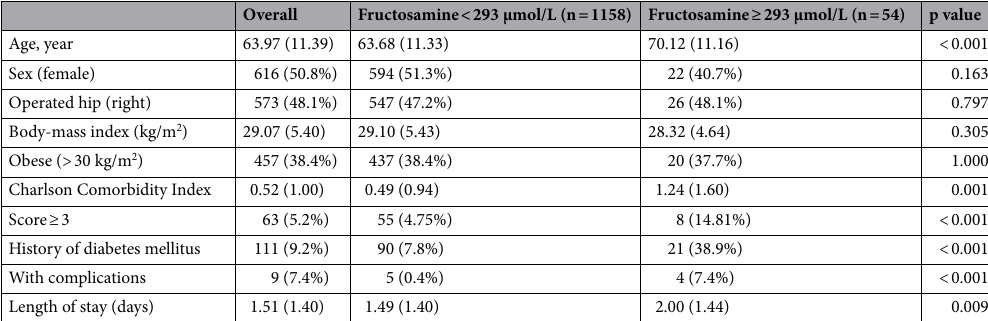
Table 1. Demographic characteristics and comorbidities of the entire cohort and differences between those with fructosamine levels below and above 293 µmol/L. Data are presented as mean values (SD) or as numbers (%). *Excluding diabetic element of